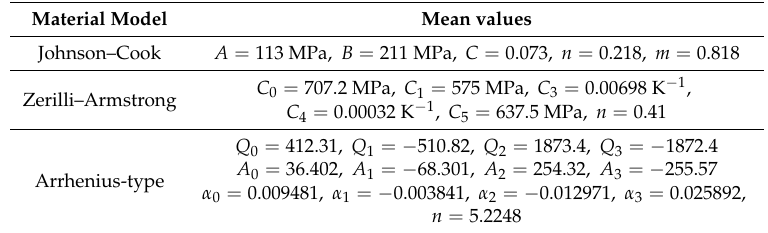
Table 2. Mean values for the parameter distributions according to literature [19,33].